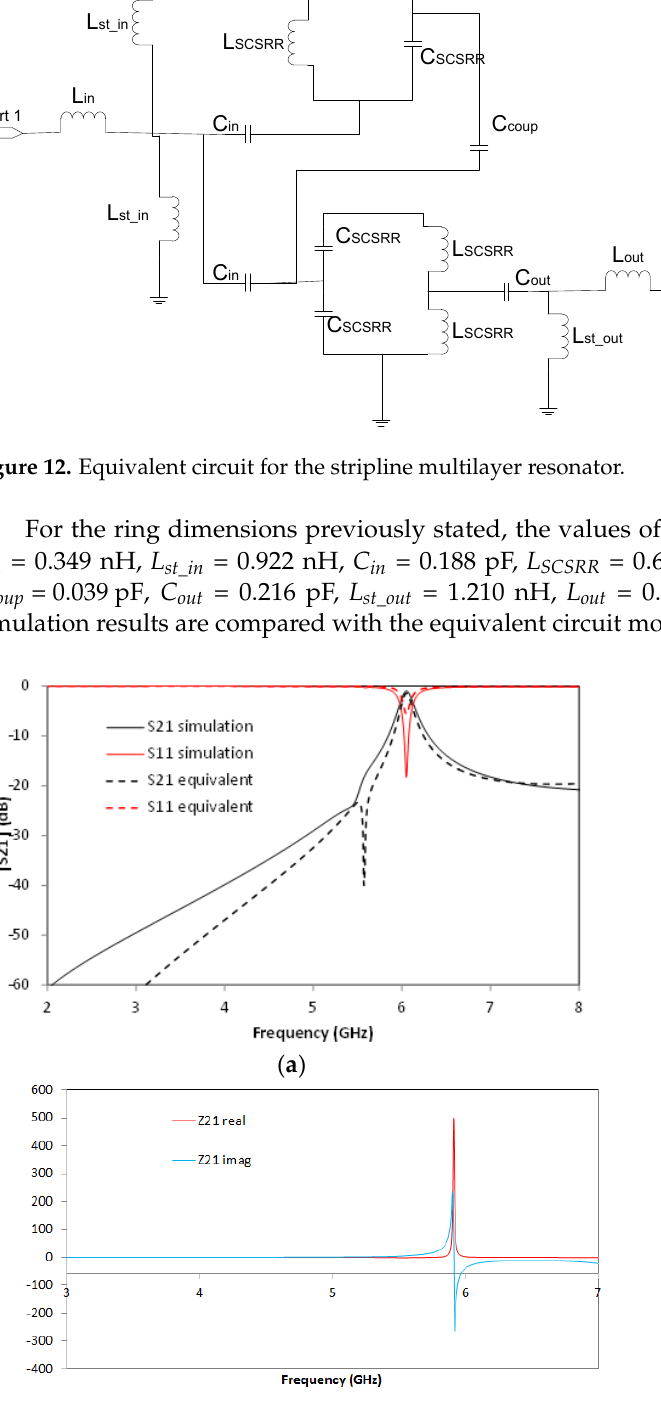
Figure 13. (a ) Simulated S11 (solid red line), simulated S11 for the equivalent circuit model (dashed red line), simulated S21 (solid black line), simulated S21 for the equivalent circuit model (dashed black line). ( b ) Impedance graph: Z21 real part (solid red line), Z21 imaginary part (solid blue line). Good agreement is achieved between the circuit model presented and the results obtained in the simulation. On this device, the resonant frequency is observed at f 0 = 6.048 dB. The S-parameters values, at the mentioned resonant frequency, are insertion loss: S21 = −1 .01 dB and return loss: S11 = −1 8.25 dB. The 3 dB bandwidth at the resonant frequency